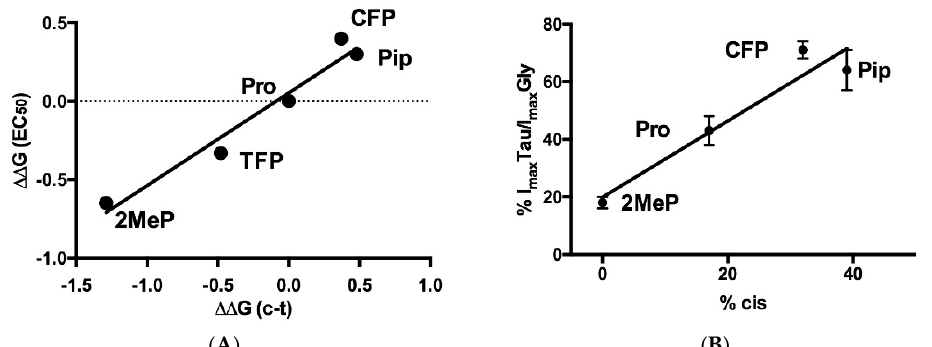
Figure 9. ( A ) Relationship between EC 50 s and cis-trans preferences for Pro and analogues at position 146. All values are relative to Pro. R 2 = 0.96, slope = significantly non zero p = 0.004. Cis-trans (c-t) values for Pip and CFP from Limapichat et al. [24], for TFP from Pandey et al. [25], and for 2MeP from Kang & Park [26]). ( B ) Relationship between maximal Tau /Gly induced responses (Figure 4) and % cis (from Limapichat et al. [24]); R 2 = 0.92, slope = significantly non zero p = 0.04.